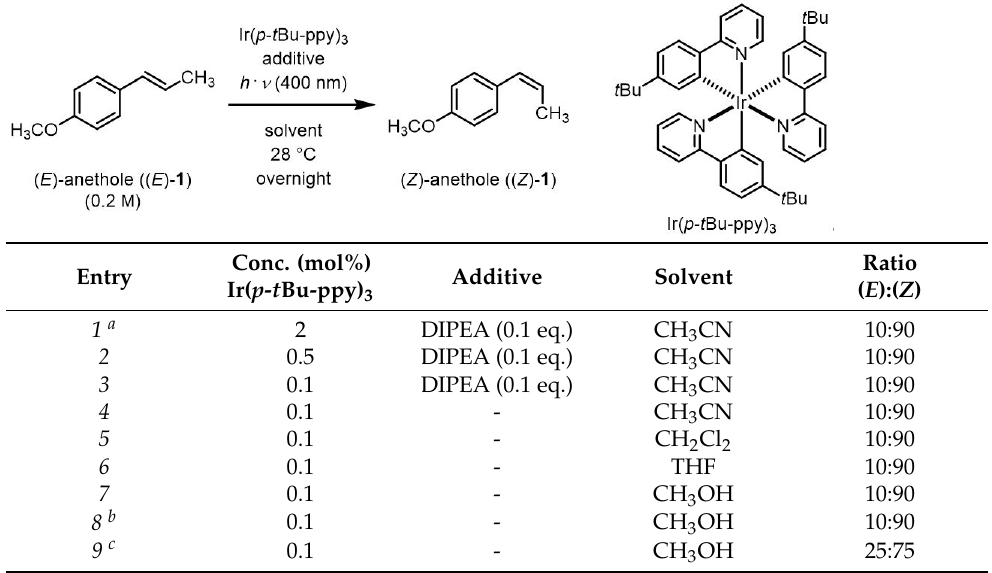
Table 2. Optimization of reaction conditions for the photoisomerization of ( E )-anethole into ( Z )-anethole using Ir( p - t Bu-ppy)3 as photosensitizer. The conversion was determined by 1H NMR spectroscopy of crude